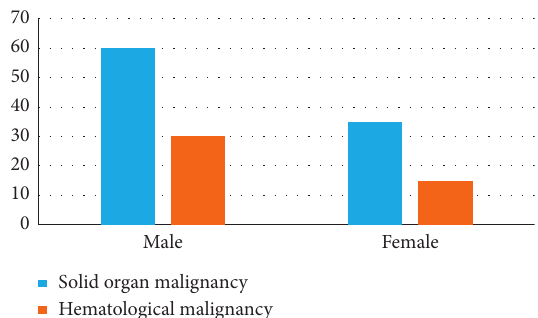
Figure 2: Gender-wise distribution of the cancer patients with documented bacterial